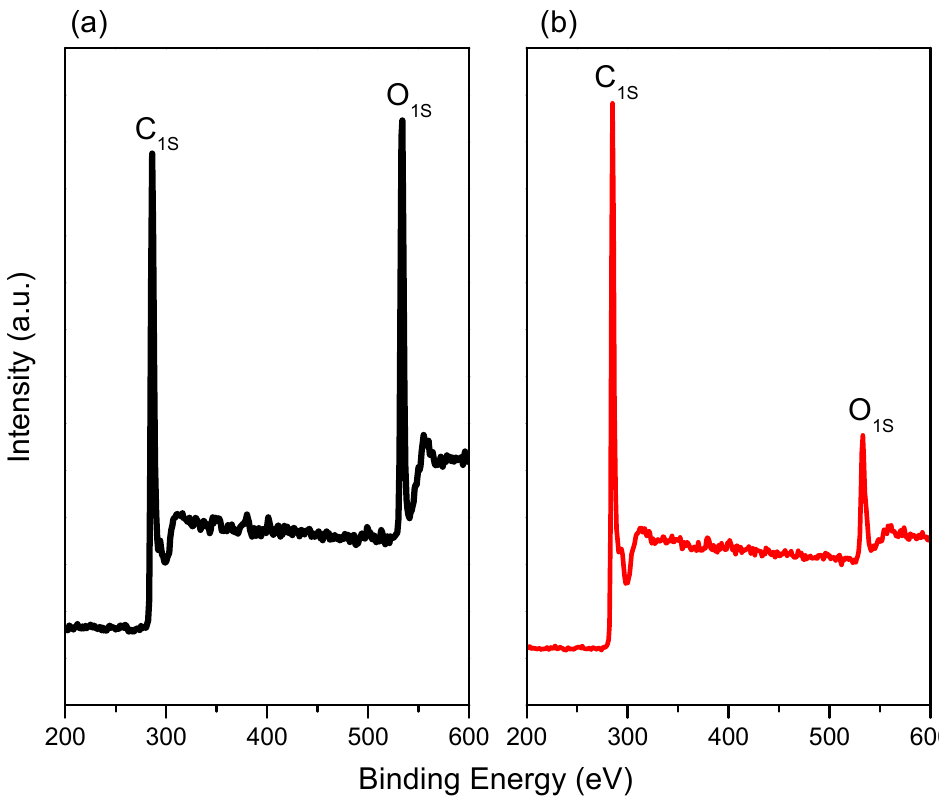
Figure 7. XPS profile of ( a ) TPE-CPOP1-800 and ( b ) TPE-CPOP2-800.